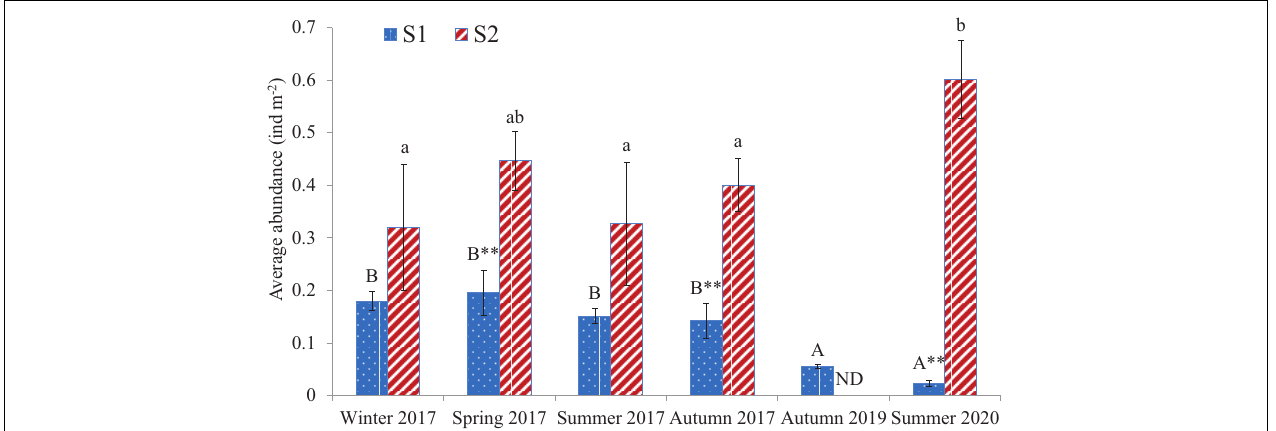
FIGURE 6 | Temporal variation in average abundance of Holothuria leucospilota [mean ± SD ( n = 3); ND = no data]. Different superscript letters indicate significant differences in time within a site; asterisks ( ∗ ) indicate significant differences between sites at the same time ( ∗∗ P < 0.01).